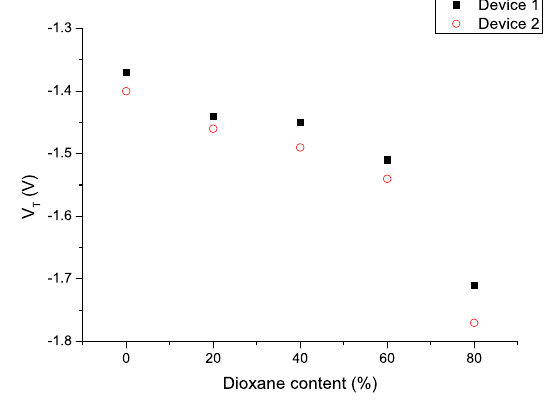
Figure 5. Average threshold voltage of two typical devices as a function of the dioxane content in the water − dioxane mixture exposed to the